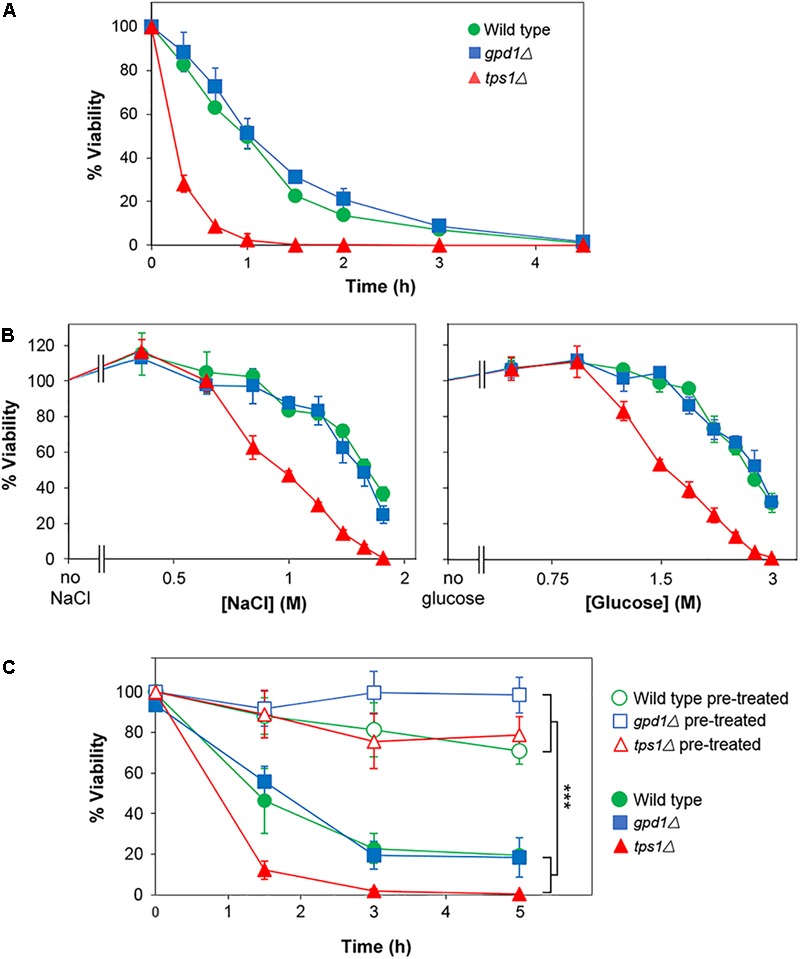
TPS1 but not GPD1 confers resistance to acute glucose and salt stresses, without altering heterogeneity. (A)
S. cerevisiae BY4741 (wild type) or isogenic deletion mutants gpd1Δ or tps1Δ were inoculated to YEPD broth containing 2 M salt (NaCl). Samples were taken at intervals and spread plated to YEPD agar for assessment of viability (colony forming ability). (B) Strains were inoculated to YEPD broth supplemented with the indicated salt or glucose concentrations. After 3 h, samples were spread plated to YEPD agar for assessment of viability. (C) Cultures were either cultured as normal (open symbols) or with 1 h pre-treatment at 0.5 M salt (NaCl; closed symbols) before inoculation to YEPD broth containing 2 M NaCl. At intervals, samples were spread plated to YEPD agar for assessment of viability. All data are means ± SD from triplicate cultures. ∗∗∗p < 0.001, unpaired t-test.